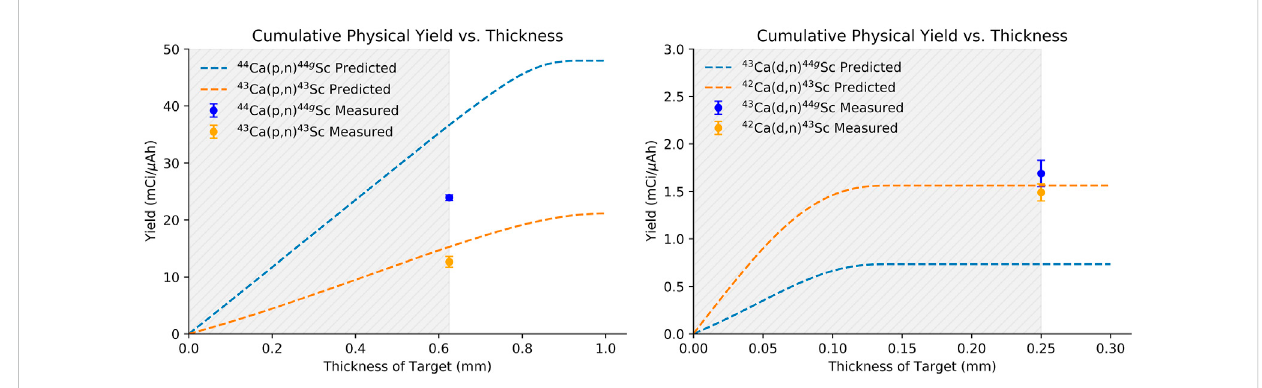
FIGURE 6 Measured production yields compared toliteraturereported crosssections fi ttedtoTENDL_19predictedcurvesfor 13.6 MeVincidentprotons (left) and5.8 MeVincidentdeuterons(right)(deWaal,etal.,1971b;Levkovski,1991;Koningetal.,2012;Krajewski,etal.,2013;Carzaniga,etal.,2017;Carzaniga, et al.,